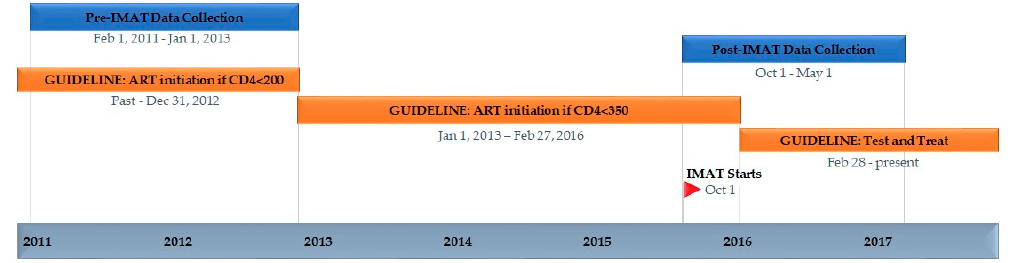
Figure 1. Timeline anti-retroviral therapy (ART) initiation guidelines shown in orange; data collection pre- and post-Integrated Methadone and Anti-Retroviral Therapy (IMAT) shown in blue; IMAT start date Oct 1, 2015 identified with the flag.